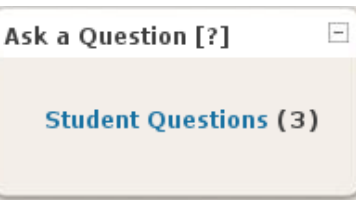
Figure 8 . Moodle instructor plugin to the QA